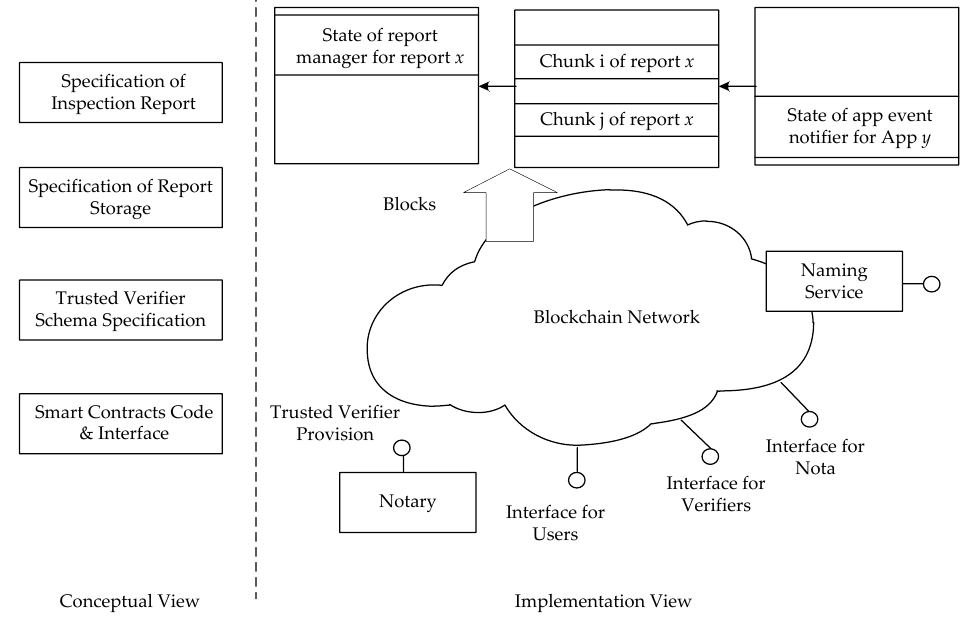
Figure 5. The overview of the proposed SCIRM framework.